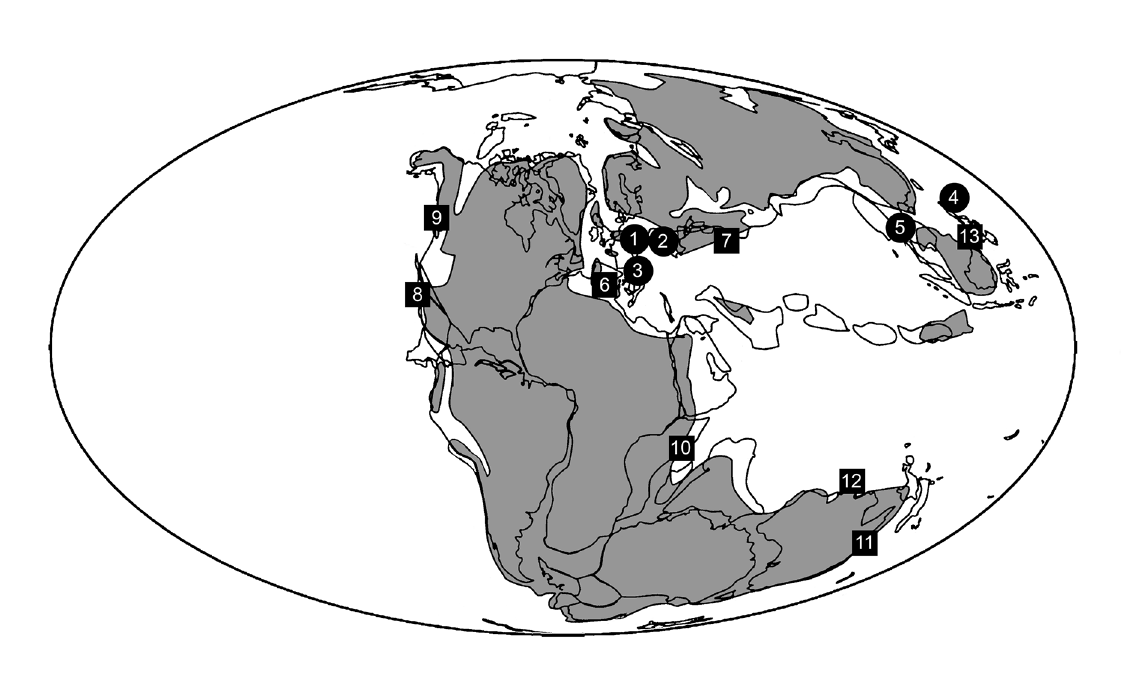
Fig. 4. Palaeogeographic reconstruction for the Middle Triassic [after Smith et al. (1994)] with positions of currently known Triassic ophiuroid occurrences (grey areas indicate emerged land). Round dots indicate assemblages quantitatively assessed in this study (see Table 1 for details). 1.